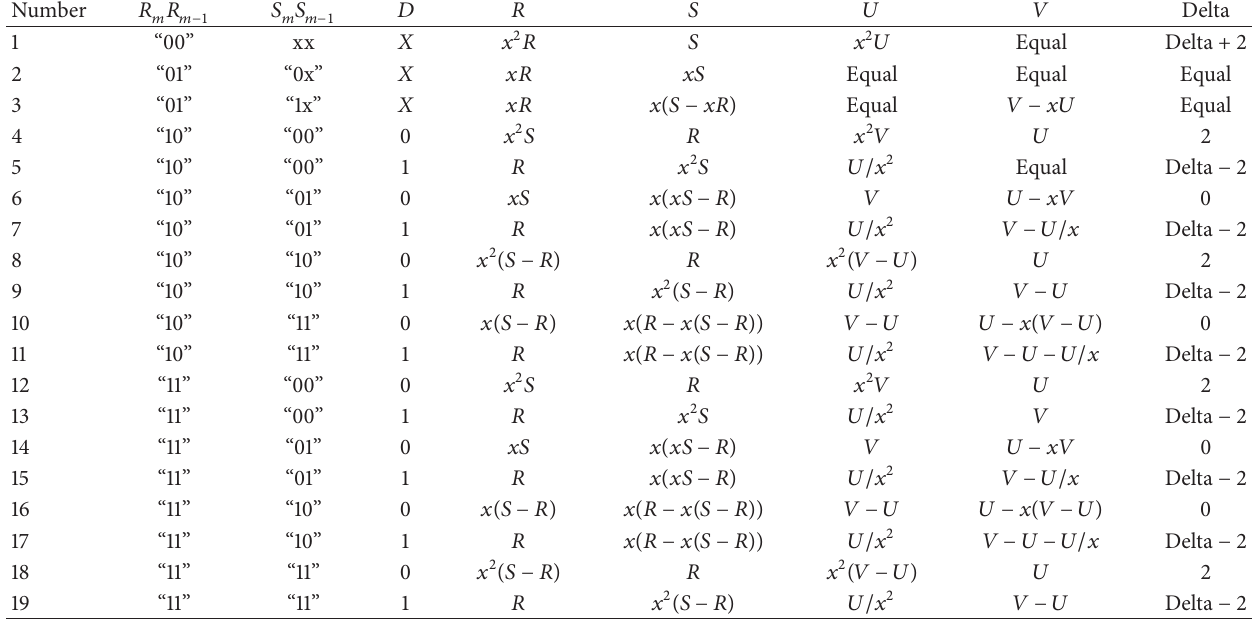
Table 1: GF( 2 𝑚 ) divider combinational